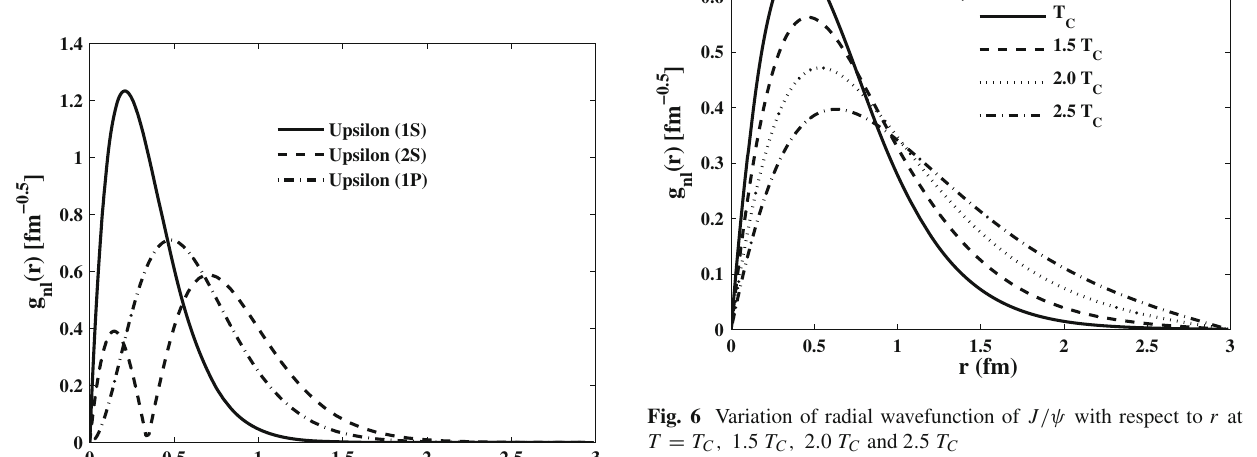
Fig. 3 The variation of radial part of wavefunction of different char- monia states with respect to r . Solid curve represents the 1 S ( J /ψ) , dashed curve is for 2 S (ψ (cid:8) ) and dash-dotted curve represents the radial wavefunction of 1 P (χ c ) state